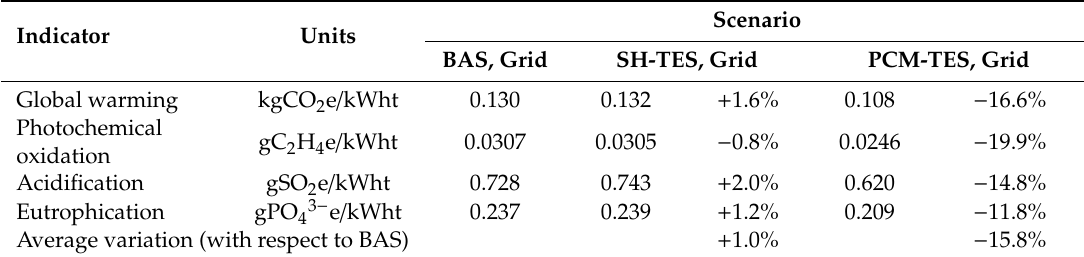
Table 4. Mid-point indicators for the three scenarios (electricity from grid).